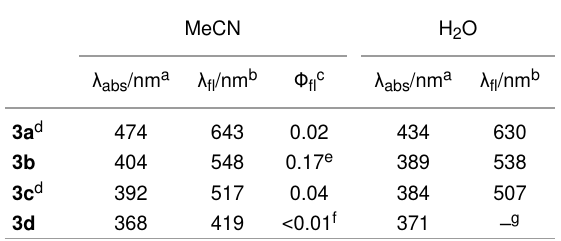
Table 1: Absorption and emission data for styrylquinolizinium deriva- tives 3a – d in MeCN and water.